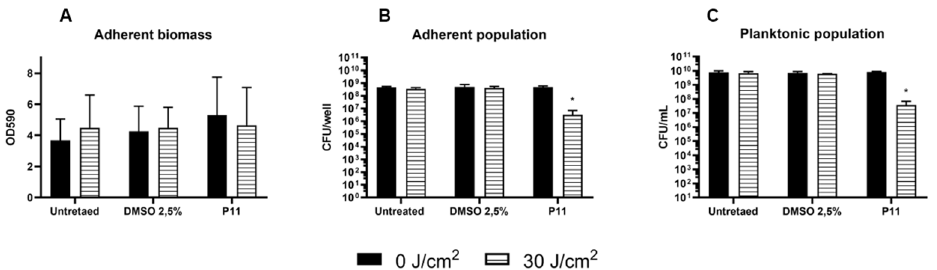
Figure 7. Assay of eradication of P. aeruginosa PAO1 biofilm by porphyrin P11. Overnight cultures of P. aeruginosa PAO1 were diluted 500-fold in M9 minimal medium added with glucose (10 mM) and casamino acids (0.2% V/V) reaching a concentration of ~10 7 CFU/mL and inoculated in 12-well microplate to let form biofilm. 24 h-old biofilm was treated with PS at a concentration of 30 µM. After dark incubation for 1 h, biofilm was irradiated (30 J/cm 2 ). After irradiation, the adherent biomass (OD 590 ) (A) and viable counts from sessile (CFU/well) (B) and planktonic phases (CFU/mL) (C), re- spectively, have been evaluated. Data represent the mean of at least three independent experiments ± the standard deviation. Statistical analyses were performed by one-way ANOVA (* p < 0.05). On the other hand, the photoinactivation protocol (P11 30 µM, 30 J/cm 2 ) applied to a 24 h grown biofilm of P. aeruginosa PAO1 expressing GFP showed a clear antimicrobial